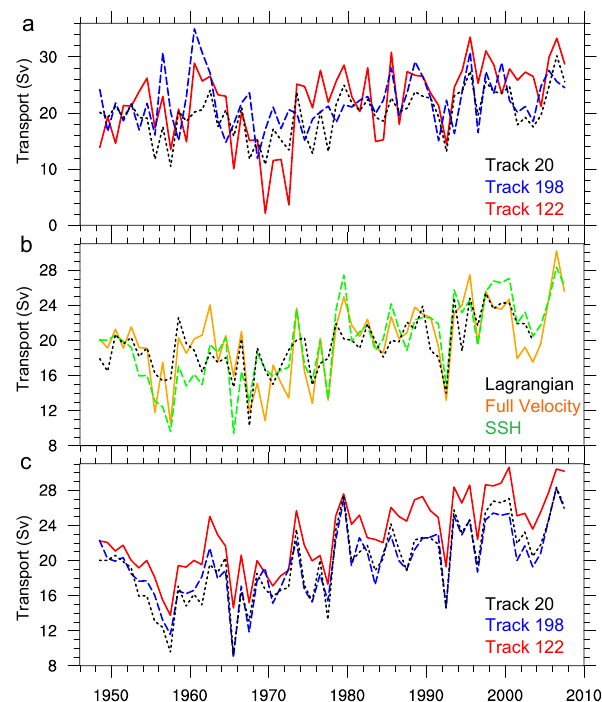
Figure 7. (a) Leakage computation from the integration of model velocity along three satellite tracks. (b) Comparison between three methods to compute the leakage over track 20 in the model: La- grangian parcels (black), integration of full model velocity (orange) and derived from the SSH (green). (c) Leakage computation from the SSH method in the model. All the curves show annual